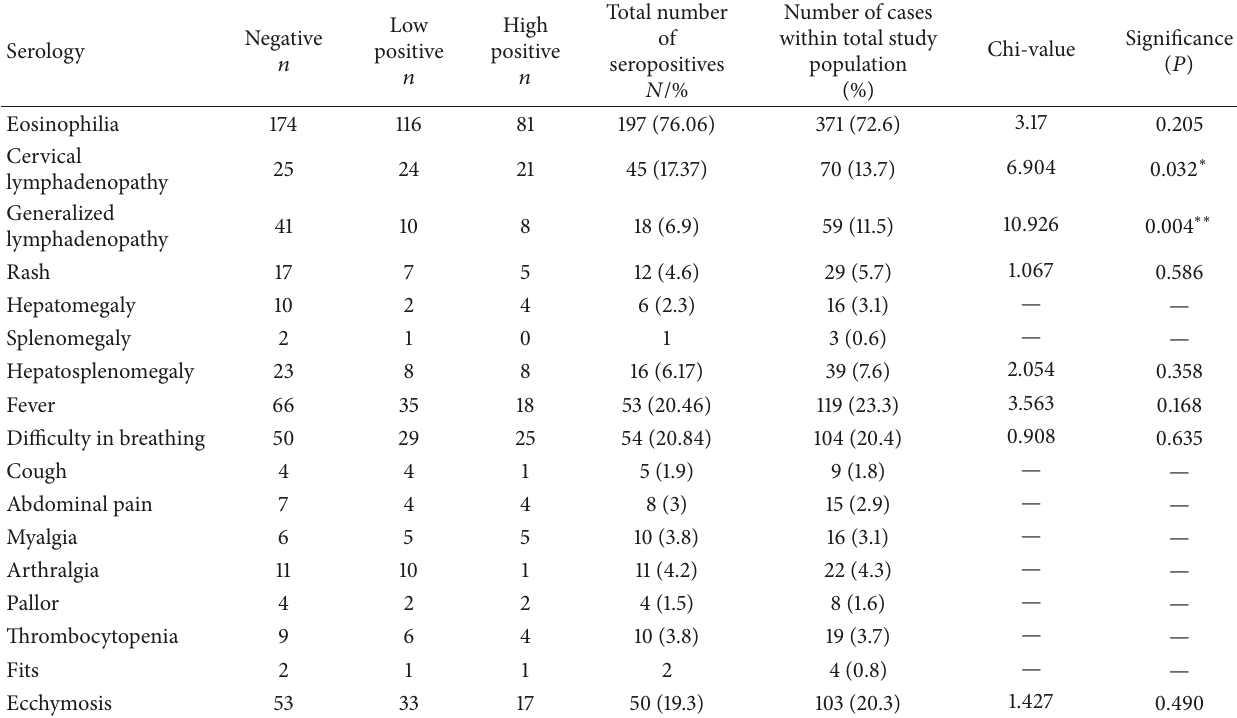
Table 5: Prevalence of clinical features and association with serological